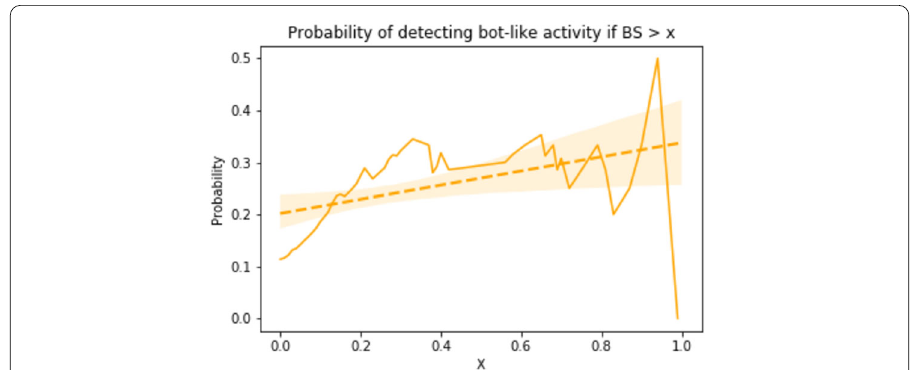
Figure 10 Probability of detecting bot-like activity for BotScore ≥ x , computed as the proportion of accounts with BotScore ≥ x that were manually annotated as alleged bots: the higher the BotScore, the higher the chance of detecting bot-like